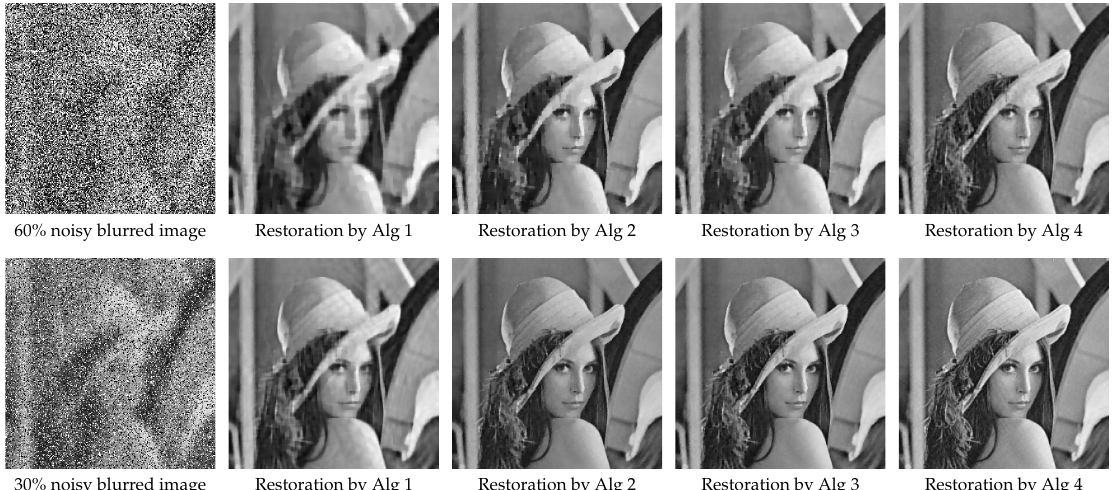
Figure 3. Image restoration for blurred Lena image with 60% or 30% salt-and-pepper noise.